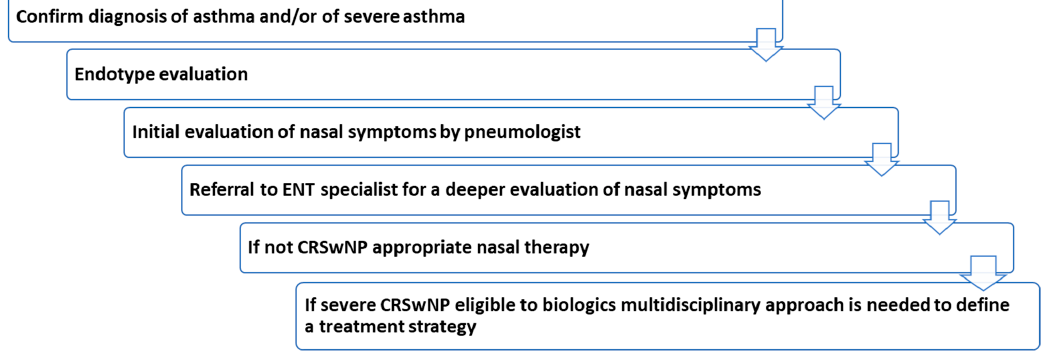
Figure 3. Summary of the first flow. ENT = otolaryngology; CRSwNP = chronic rhinosinusitis with nasal polyps.